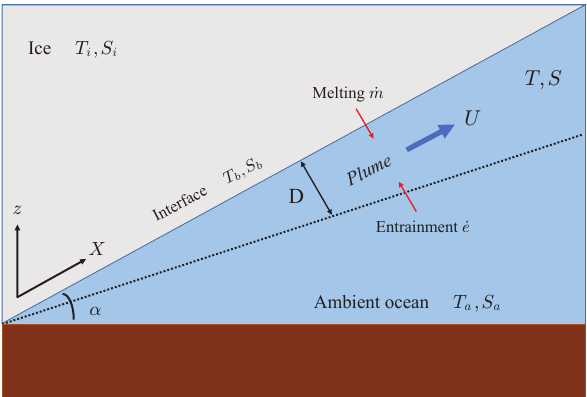
Figure 1. Schematic picture of the plume model. The plume travels upward under the ice-shelf base along the path X with speed U and thickness D while being influenced by melting and entrainment. Note that, in general, the slope angle α can vary in the direction of X